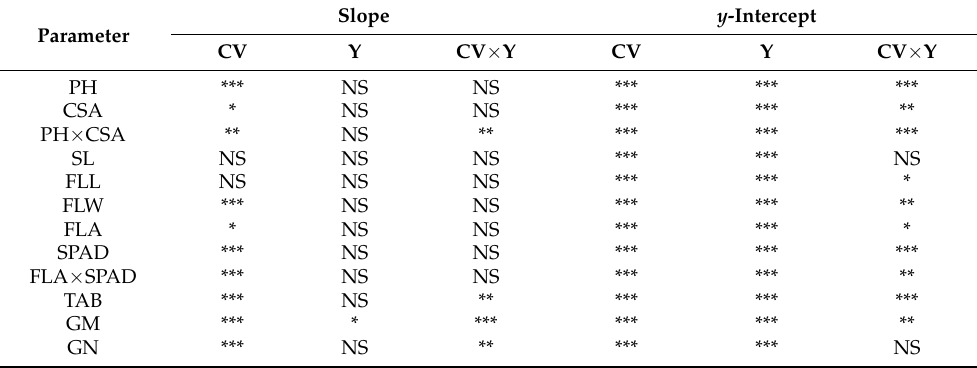
Table 2. ANOVA results for the effect of cultivar (CV), year (Y), and CV × Y interaction on the slope and y -intercept of the linear regressions established between the saturation root electrical capacitance (C R *) and various plant parameters. For abbreviations, see Figure 1. * p < 0.05; ** p < 0.01; *** p < 0.001; NS not